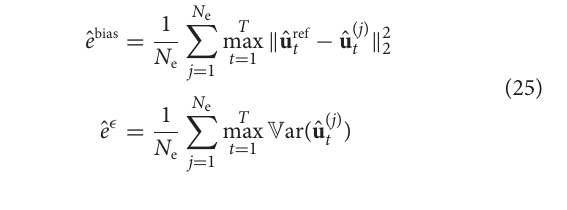
6 spatial grid) obtained from various estimators. ×